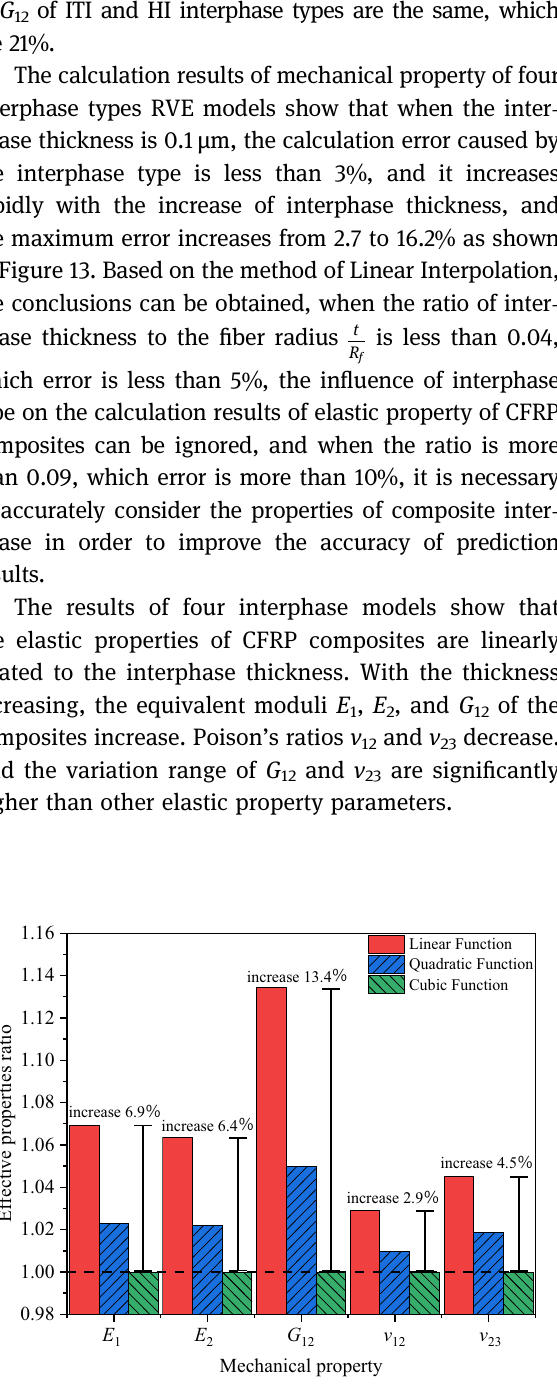
Figure 16: E ff ect of the increase of interphase properties on com - posite mechanical properties when the interphase thickness is 0.5 μ